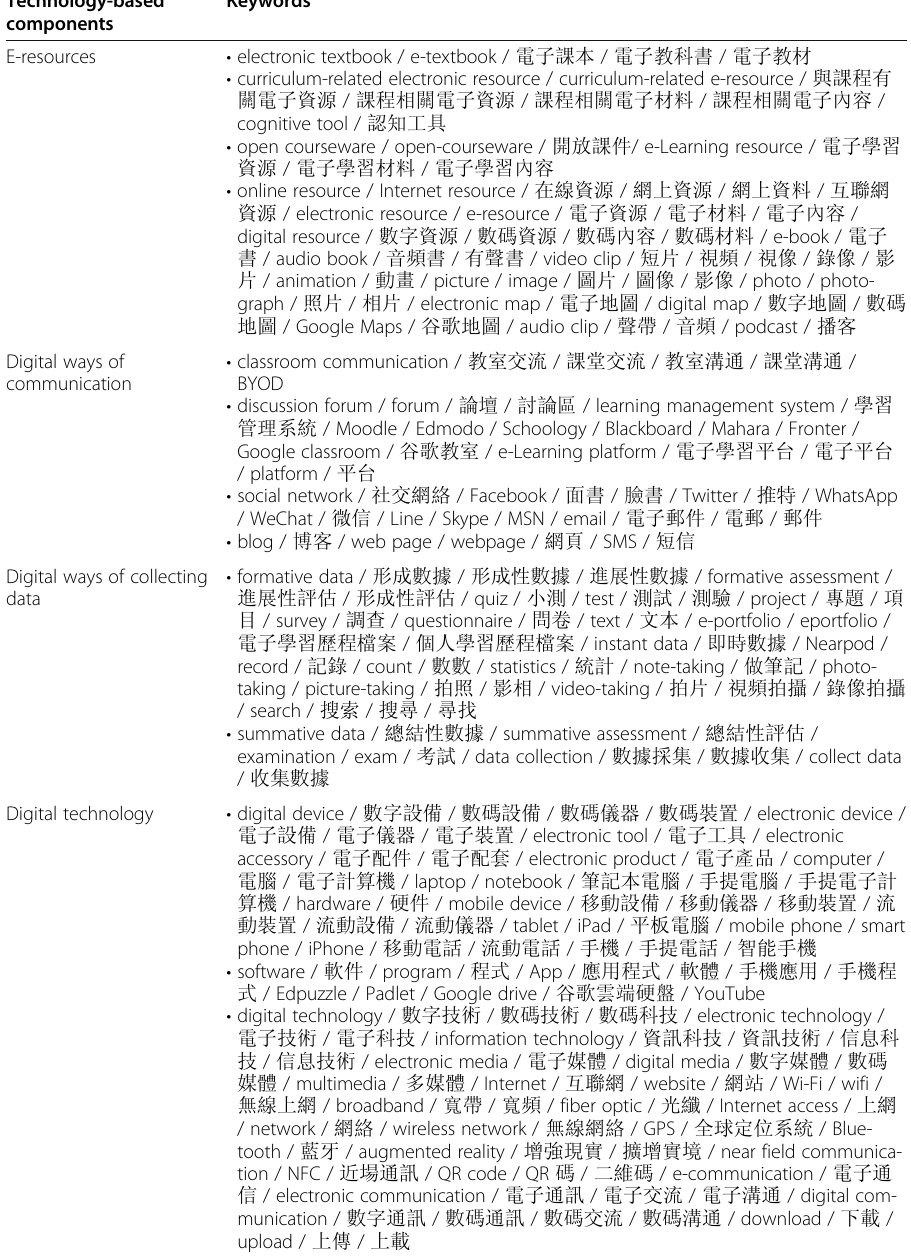
Table 1 Finalized keywords of this study on the technology dimension of the proposed e- Learning